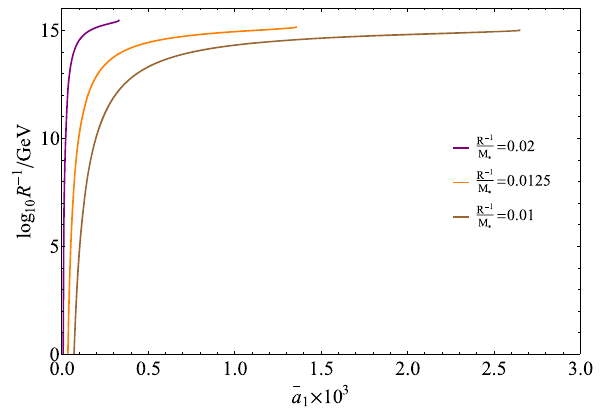
Fig. 2 The dependence of the inverse size R − 1 of extra dimension in the parameter ¯ a 1 for various reference points of ratio R − 1 / M ∗ with λ (cid:30) = 7 . 32 × 10 − 13 T